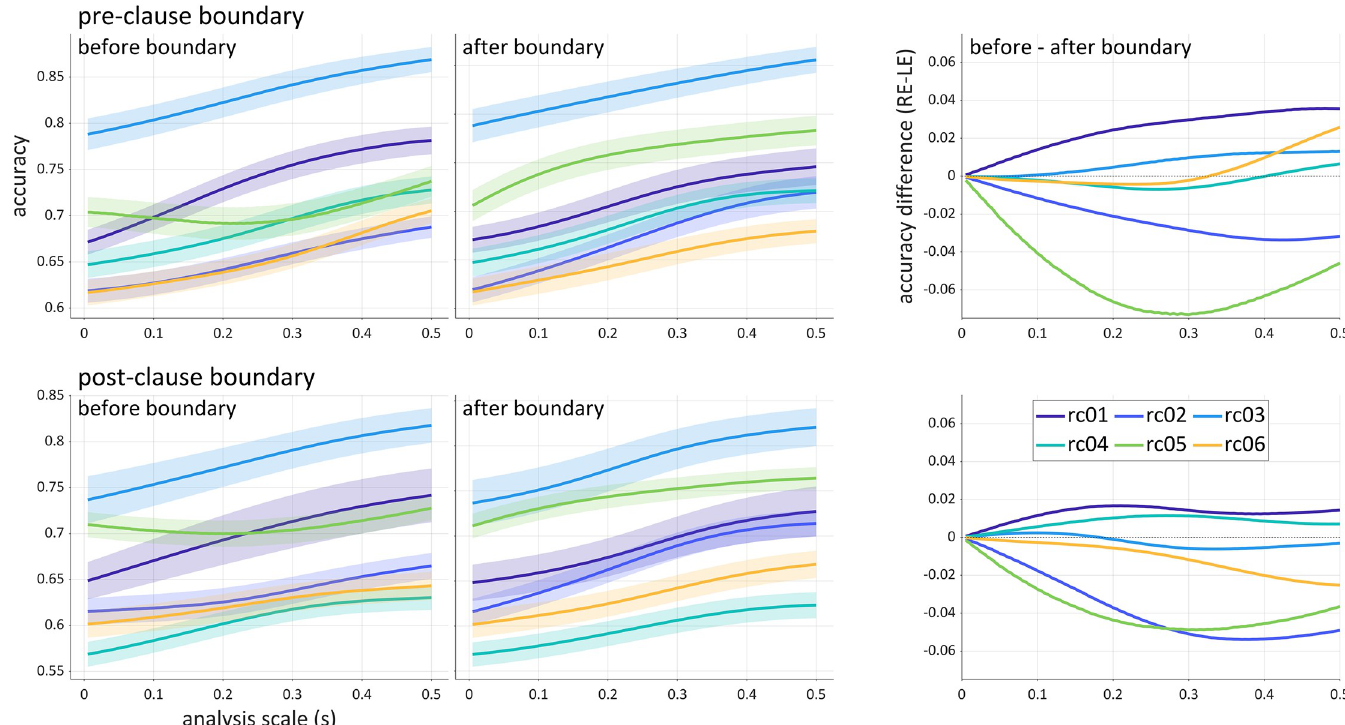
Fig 9. Comparison of accuracies before and after clause boundaries. Left panels: average accuracies as a function of scale for windows whose right or left edges (RE/ LE) align with the pre- or post-clause phrase boundary. Filled regions are ± 1.0 standard error. Right panels: difference in average accuracies (RE aligned windows–LE aligned windows). The alignment points (time 0) are the pre- and post-clause boundaries, for example: A Mr . Hobb | pre who know Mr . Rodd | post often plays tennis .